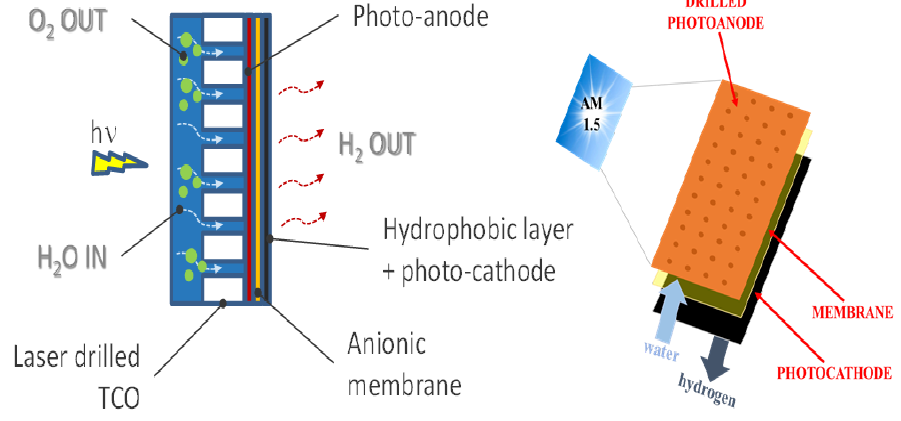
Figure 1. Sketch of reactants and products in a membrane-based photoelectrochemical tandem